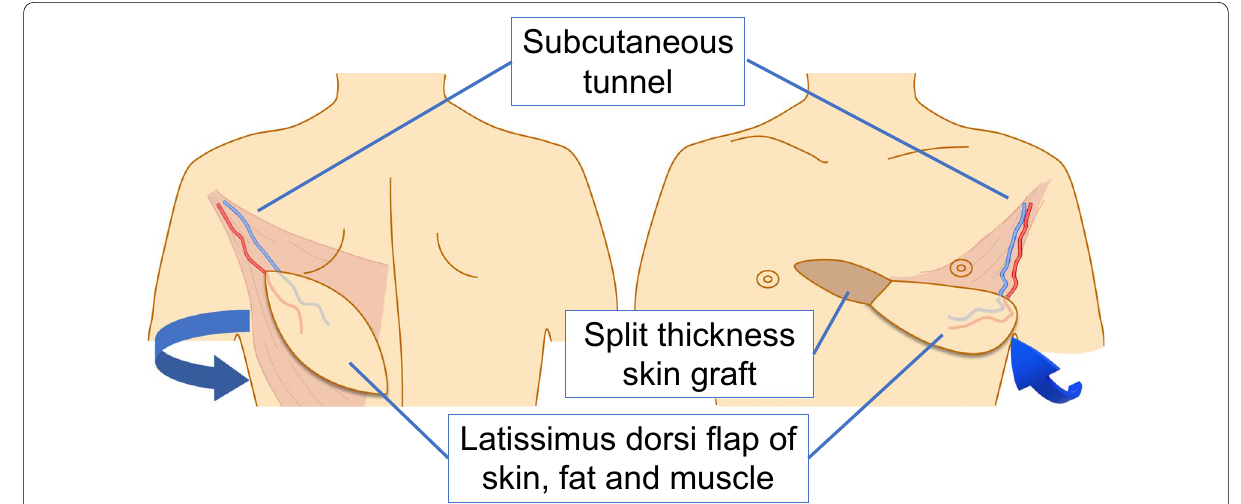
Fig. 7 Schematic of thoracic reconstruction with a pedicled latissimus dorsi myocutaneous